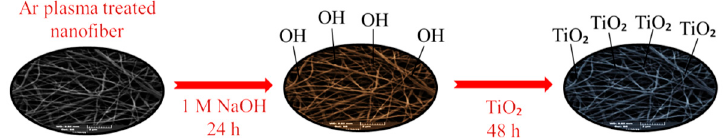
Figure 2. Schematic illustration of surface modification of PVDF/PAN nanofibrous membrane (inspired from work in [54]).